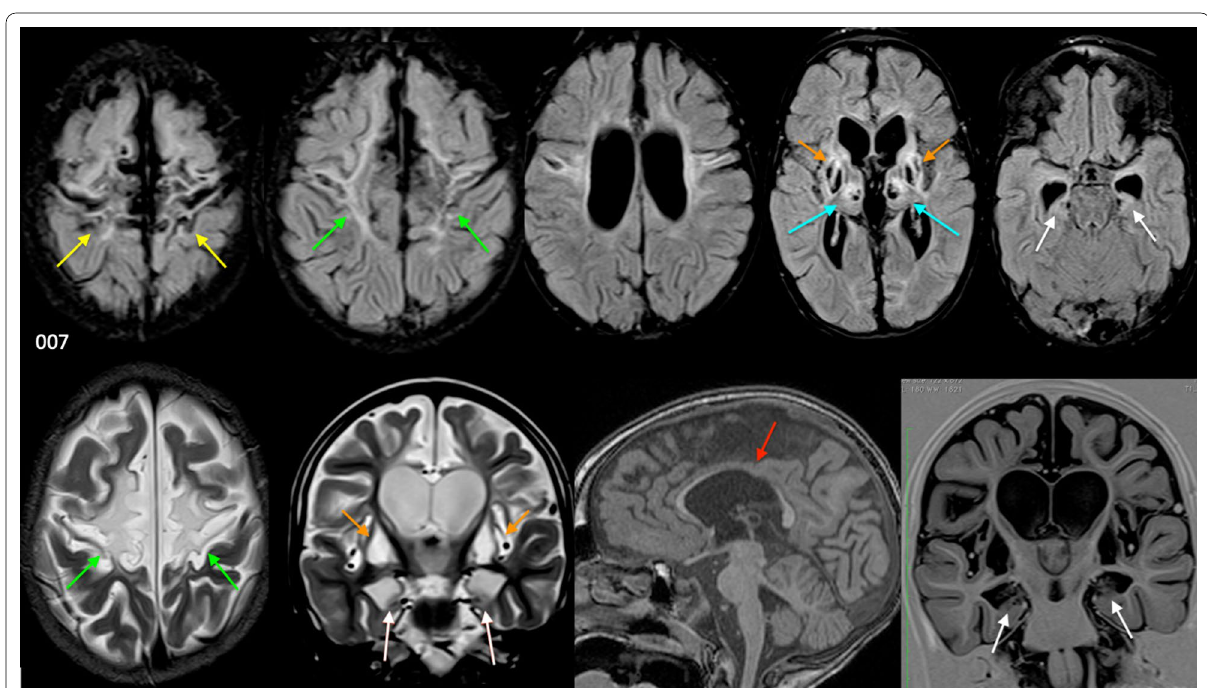
Fig. 7 Collage of MR images demonstrating the key features of the massive paramedian injury pattern. Top row left to right) axial T2‑weighted, coronal T2‑weighted, Sagittal T1‑weighted and coronal inversion recovery sequence images. These demonstrate the perirolandic injury (yellow arrows), diamond‑shaped expansion of the parasagittal cortex including the paracentral lobule (green arrows), hippocampal destruction (white arrows), putaminal necrosis (orange arrows) and thalamic (blue arrows) cavitation. The red arrow highlights the severe deafferentation thinning of the body and isthmus of corpus